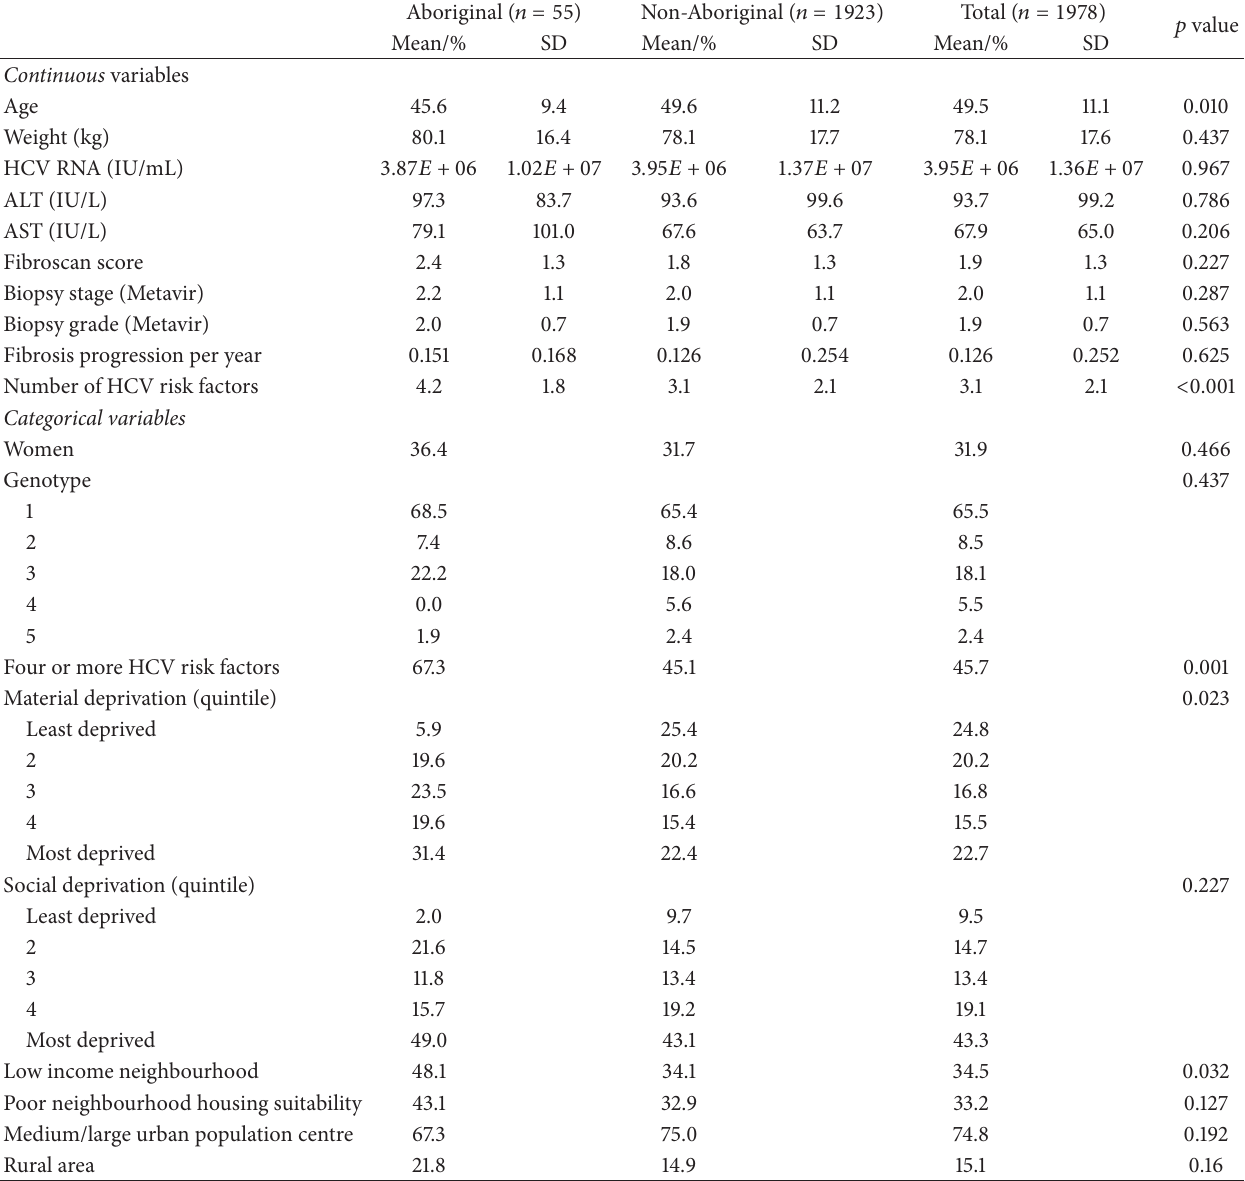
Table 1: Baseline characteristics of HCV infection according to Aboriginal